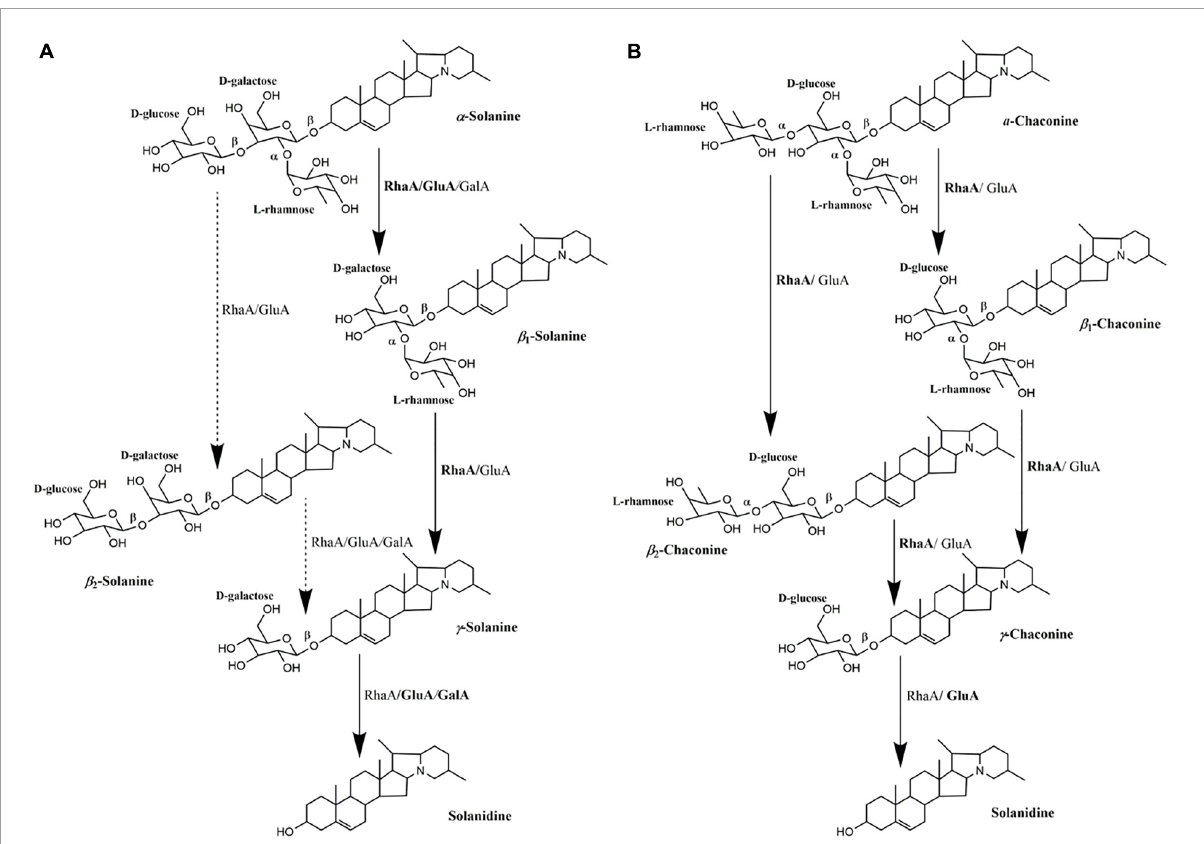
FIGURE5 Multifunctional roles of glycoside hydrolases (RhaA, GluA, and GalA) produced by Glutamicibacter halophytocola S2 in the degradation of α -solanine (A) and α -chaconine (B) . The degradation process of α -solanine and α -chaconine referred to Jensen et al. (2009). Solid arrows represent the proposed main pathway of G. halophytocola S2. The dashed arrow represents the secondary catabolic pathway. Enzyme names to the right of each arrow is the enzyme that can act on that